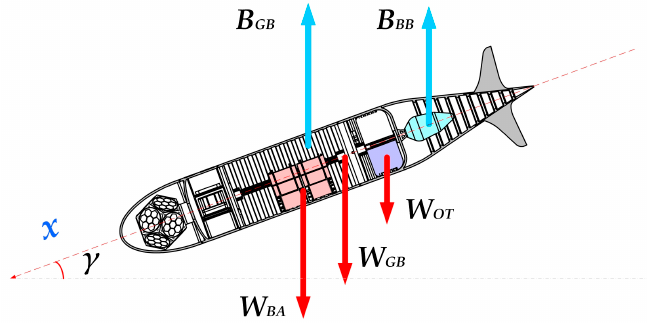
Figure 6. Drone in buoyancy Balance.